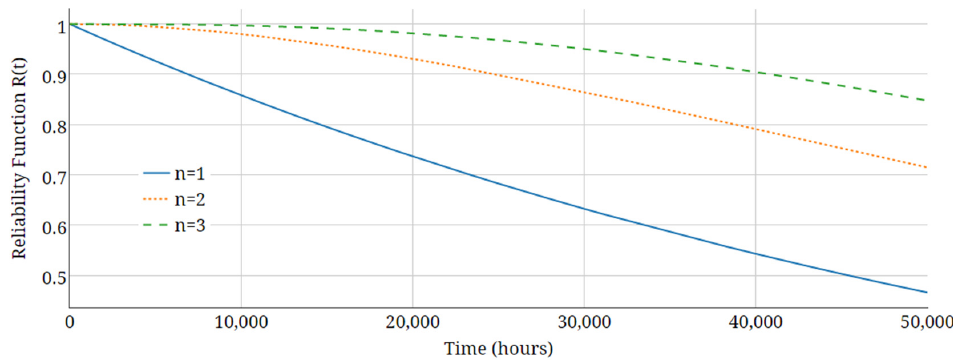
Figure 8. The effect of series redundancy on reliability of CHB.